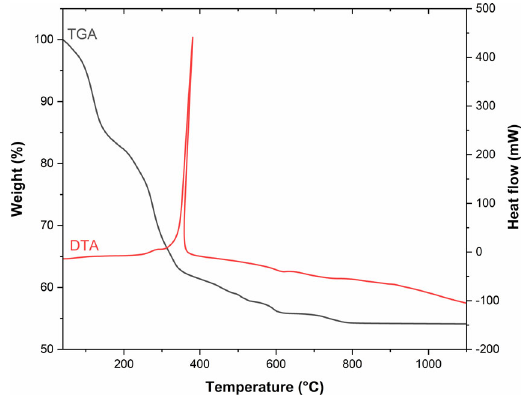
Fig. 1 TG-DTA curves of BCZT raw